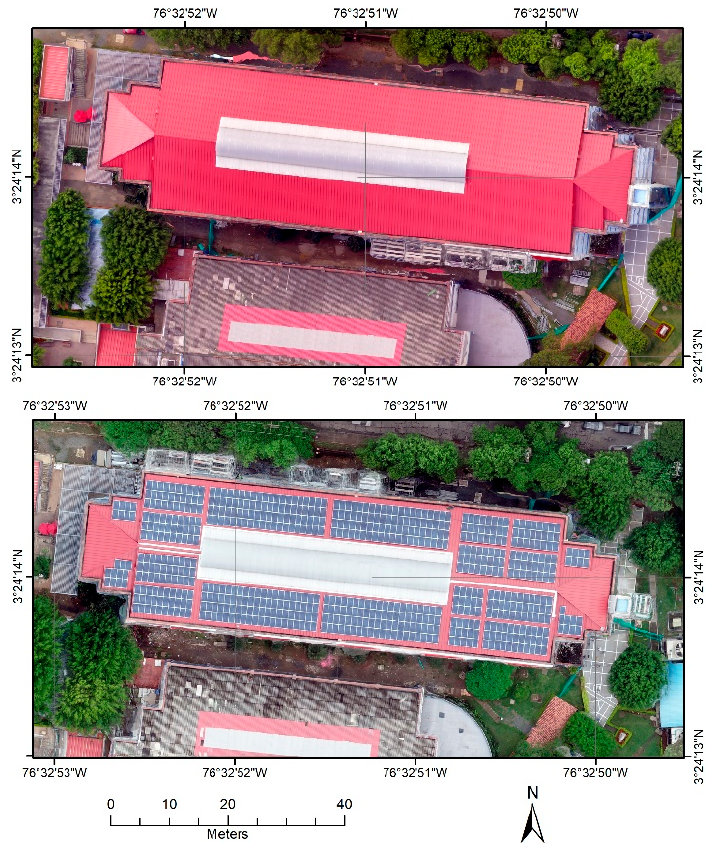
Figure 7. Mosaic of UAV images before and after the placement of the solar panels.